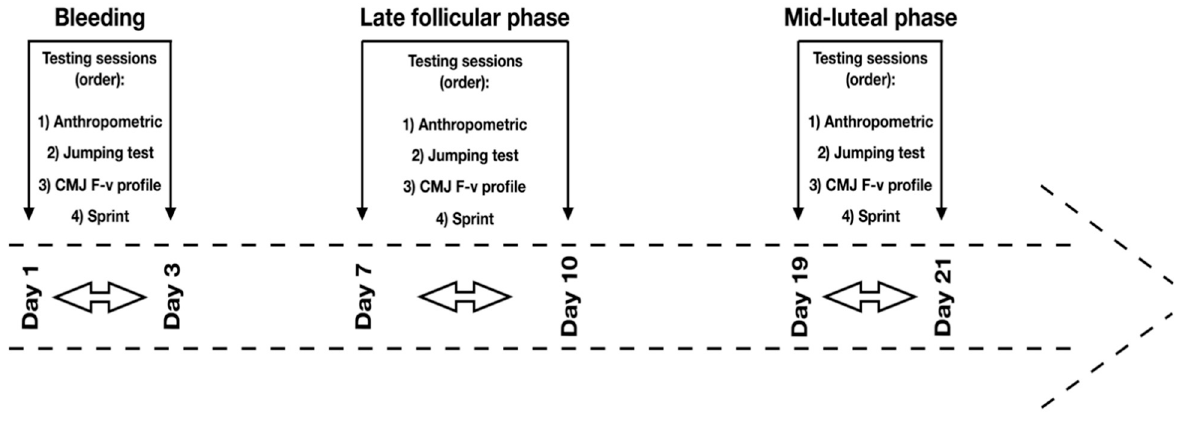
Figure 1. Visual representation of the timeline of the testing